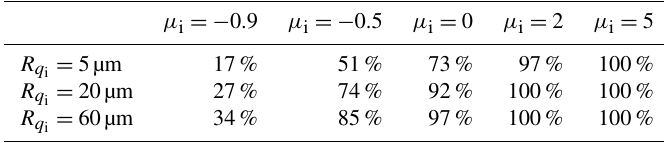
Figure A2. The relative number contributions from each radius bin of ICs under different R q width is the same based on the logarithm of the particle radius. Table A1. The contributions of ICs from the realistic size range (i.e., 1–1000µm) to the total